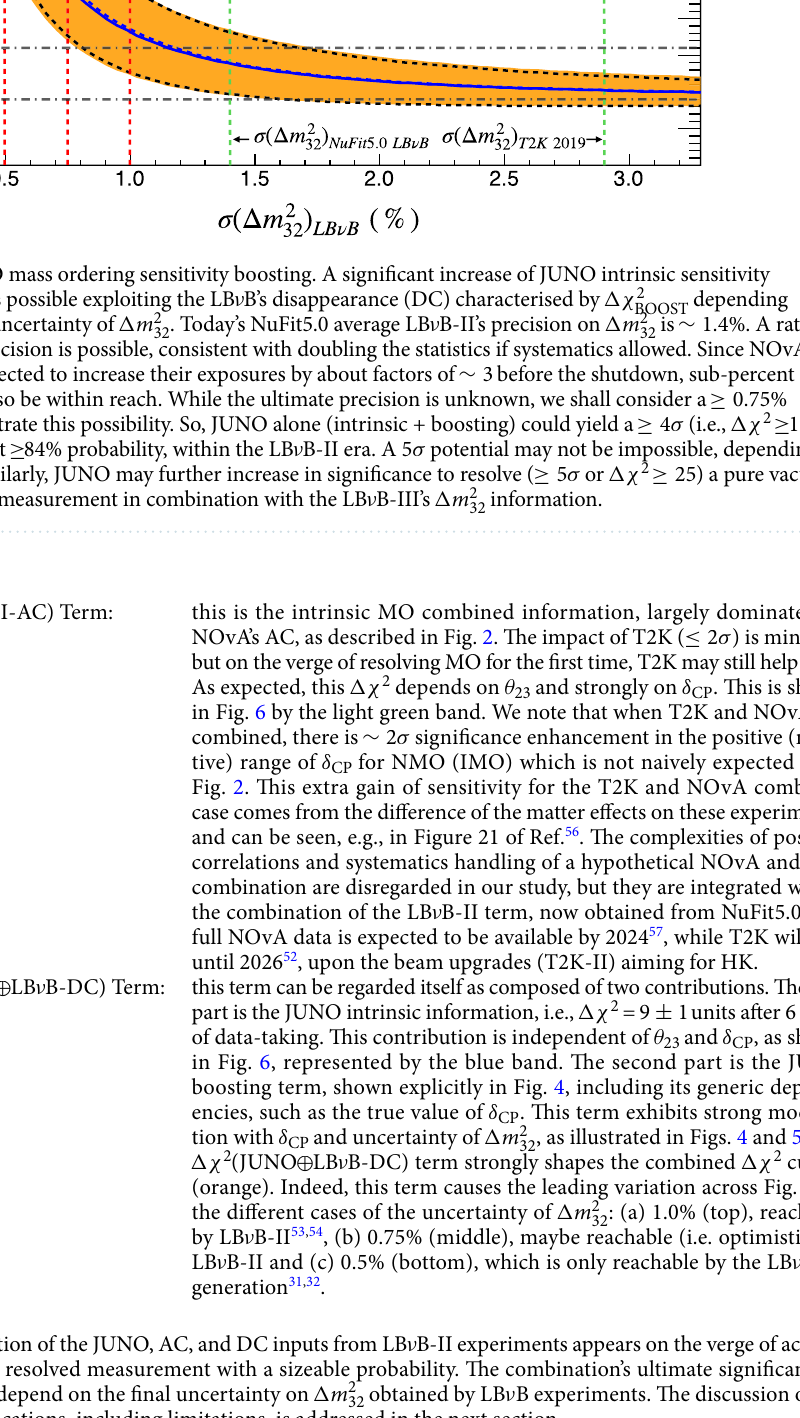
generation 31,32 . The combination of the JUNO, AC, and DC inputs from LB ν B-II experiments appears on the verge of achiev- ing the first MO resolved measurement with a sizeable probability. The combination’s ultimate significance is likely to mainly depend on the final uncertainty on (cid:31) m 2 32 obtained by LB ν B experiments. The discussion of the results and implications, including limitations, is addressed in the next section.